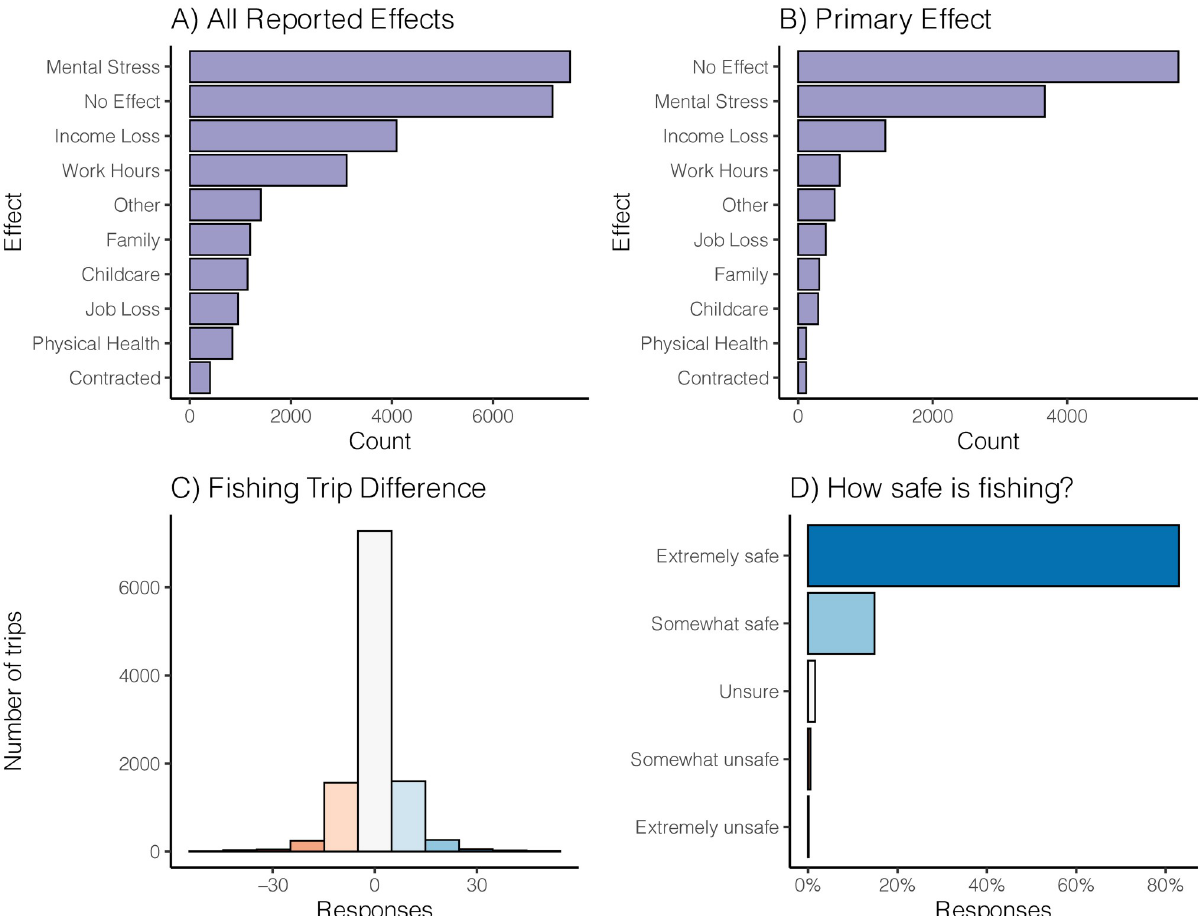
Fig 2. Pandemic effects on anglers, changes in fishing trips, and perceived safety of fishing. All reported pandemic effects (A) and the single primary pandemic effect (B) on anglers from 10 US states (see Fig 1 or Table 1 for states). Panel C shows the numeric difference in fishing estimated fishing trips during a typical spring and that of the 2020 pandemic spring. Panel D displays the perceptions of how safe recreational fishing is. (Note that data for all four panels were collected and analyzed at the state level but were aggregated here due to no strong state effects).